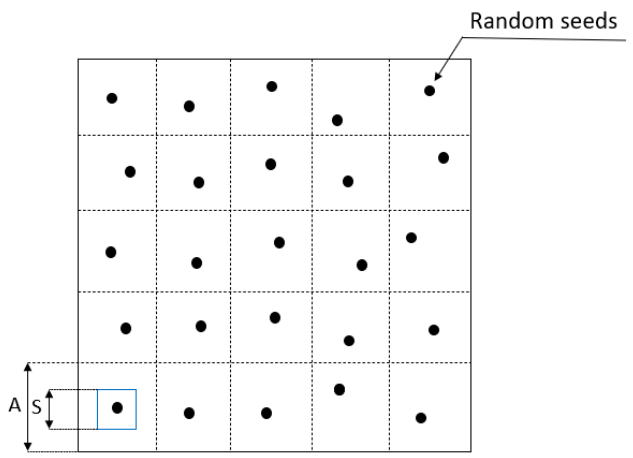
Figure 2. The distribution of random seeds in the square domain.